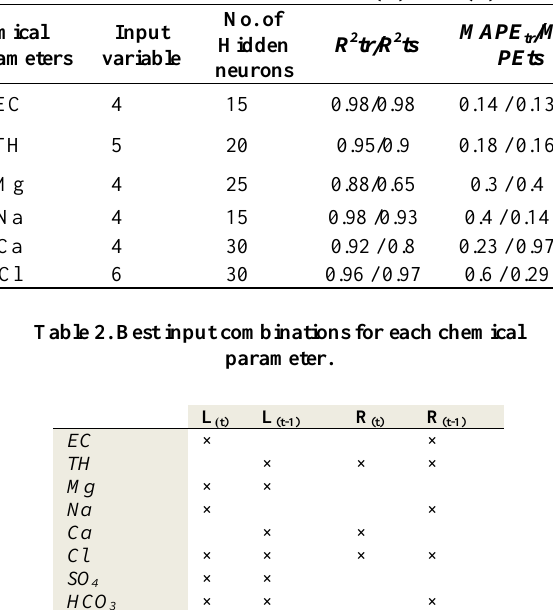
Table 3. Details of ANN model architecture in test and train